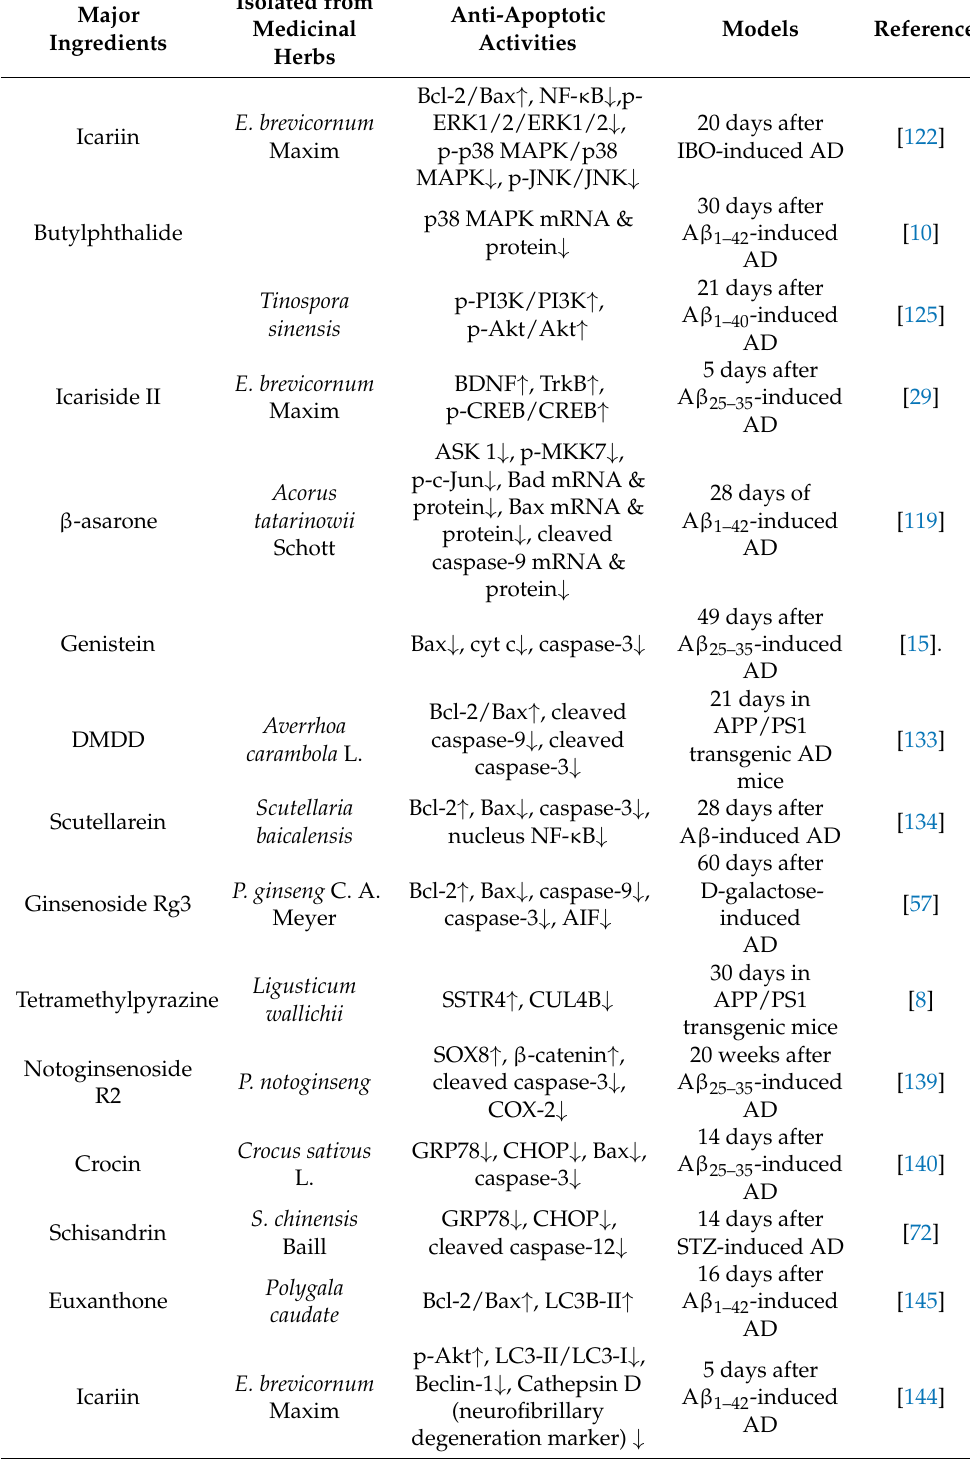
Table 6. MHDIs that attenuate A β -induced apoptosis in AD animal